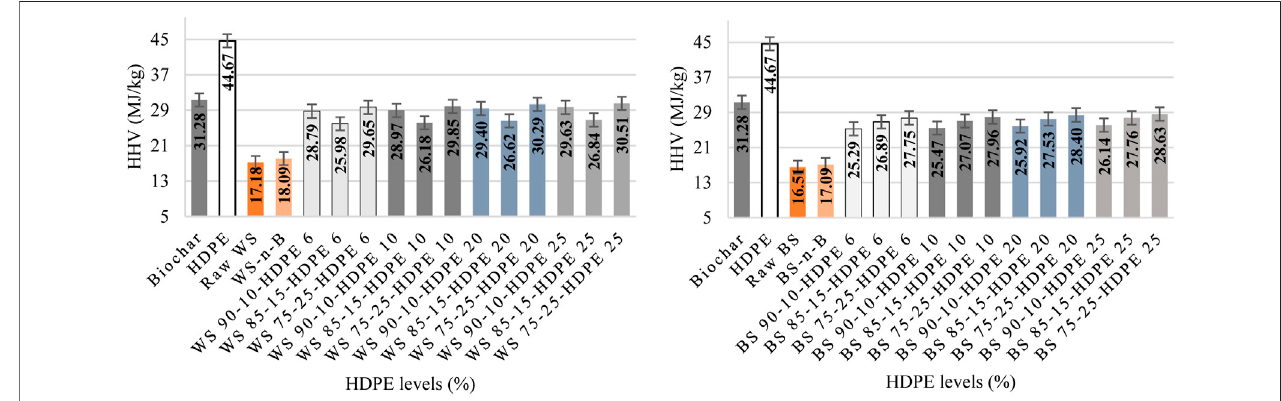
TABLE 3 | Pellets ash content and dimensional stability characteristics of microwave-torre fi ed wheat and barley straw biochar at different HDPE blends.